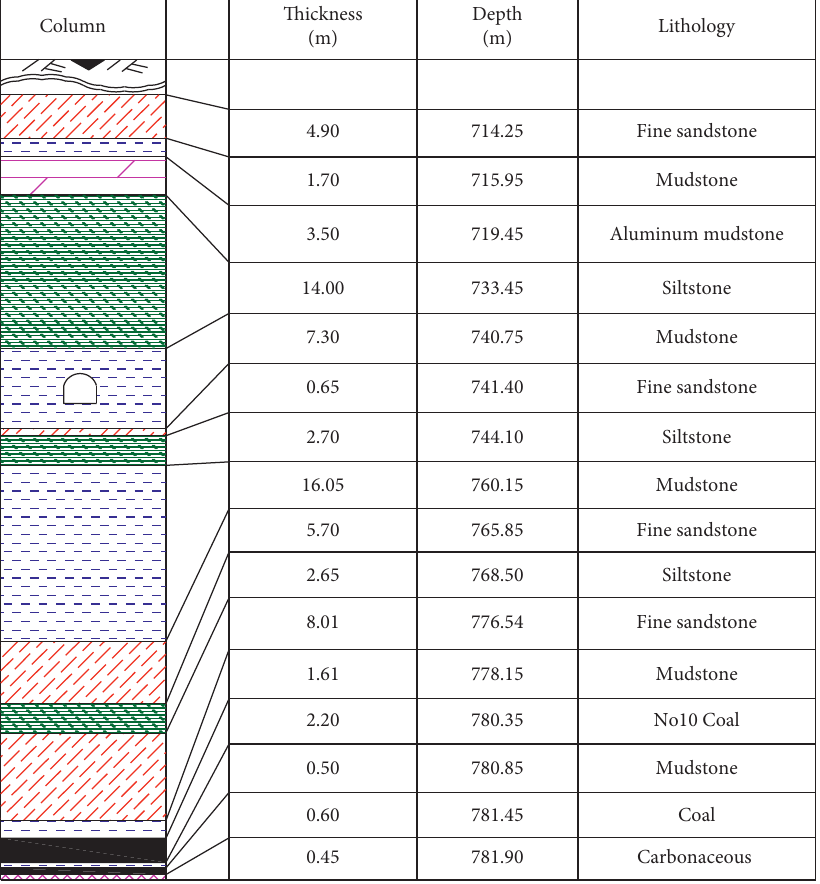
Figure 11: Sketch of stratigraphic columns in 101 track roadway.